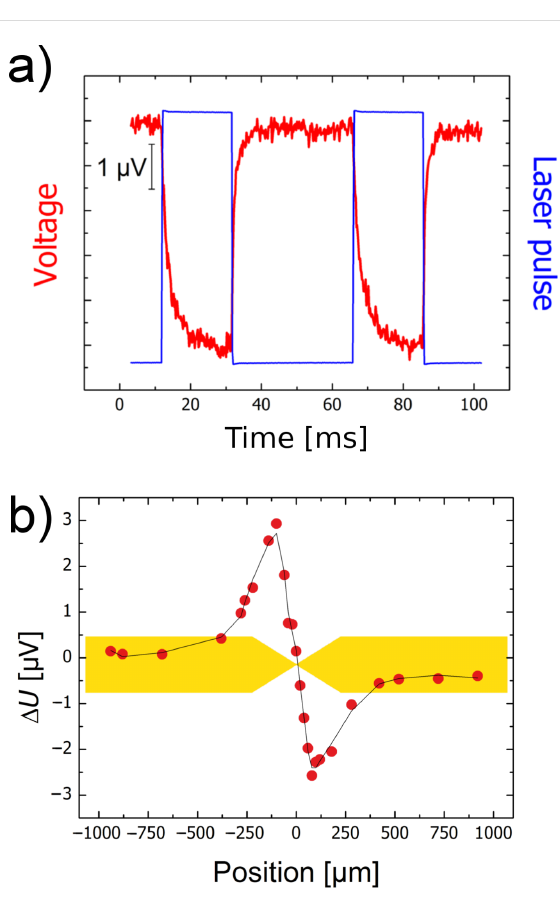
Figure 7: (a) Light-induced signal (red) of a dry, electrochemically closed break junction, and the laser pulse (blue). (b) Spatially resolved measurements of the light-induced signal as in (a). The signal drops to zero, when the laser focus is exactly aligned on the centre of the junc- tion.